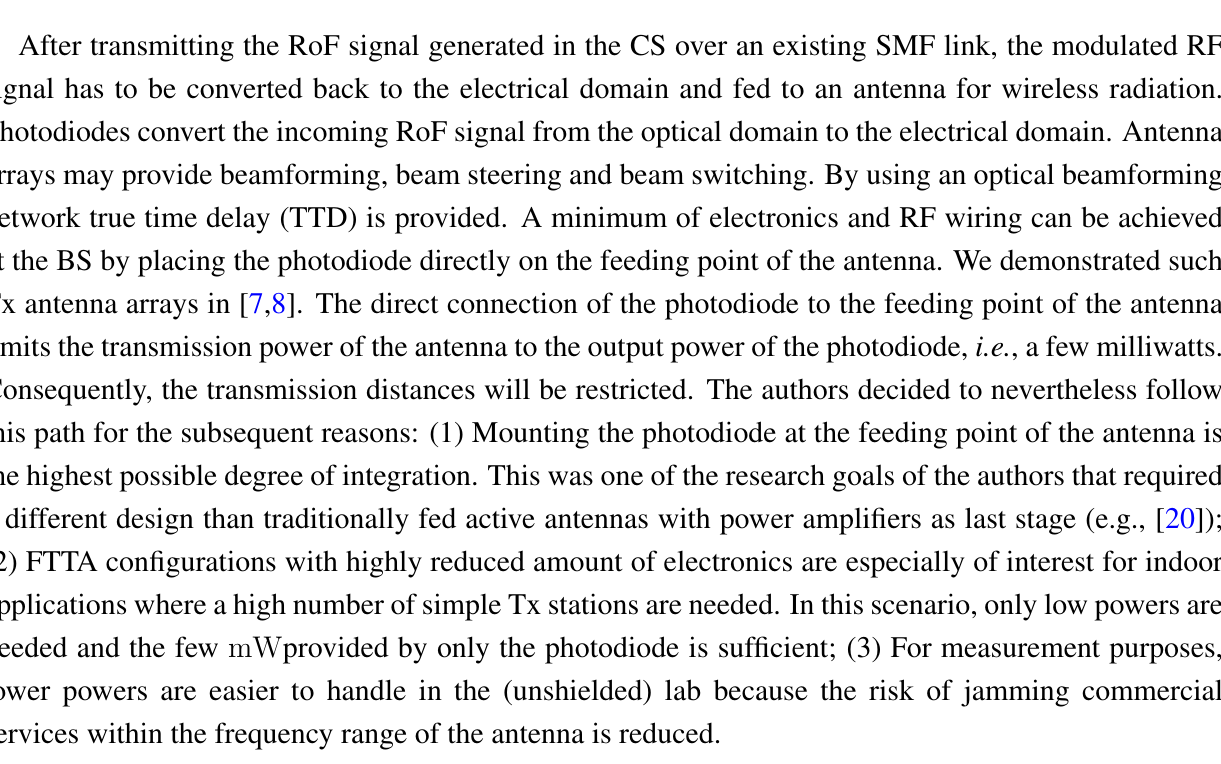
Figure 2. 2 × 1 antenna array fed by photodiodes connected by optical fiber.